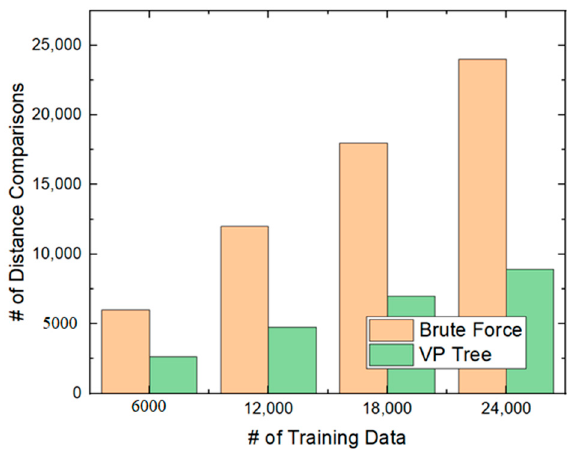
Figure 13. Number of distance comparisons.